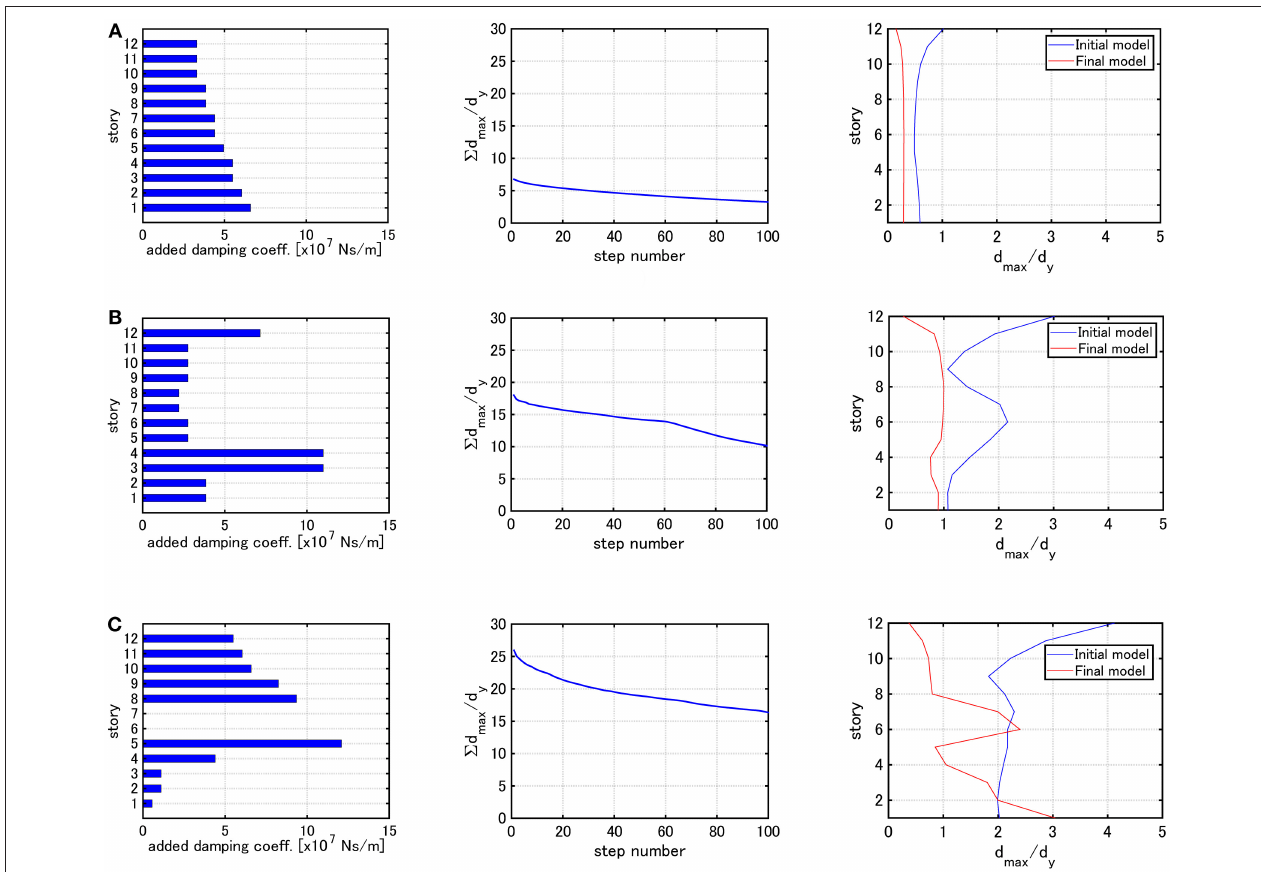
FIGURE 10 | Distribution of added damping coefficients, P d max , i / d y with respect to step number and the distribution of d max , i / d y under the critical double impulse for Model 2 (Problem 2): (A) Elastic limit, (B) V = 0.84[m/s], (C) V =